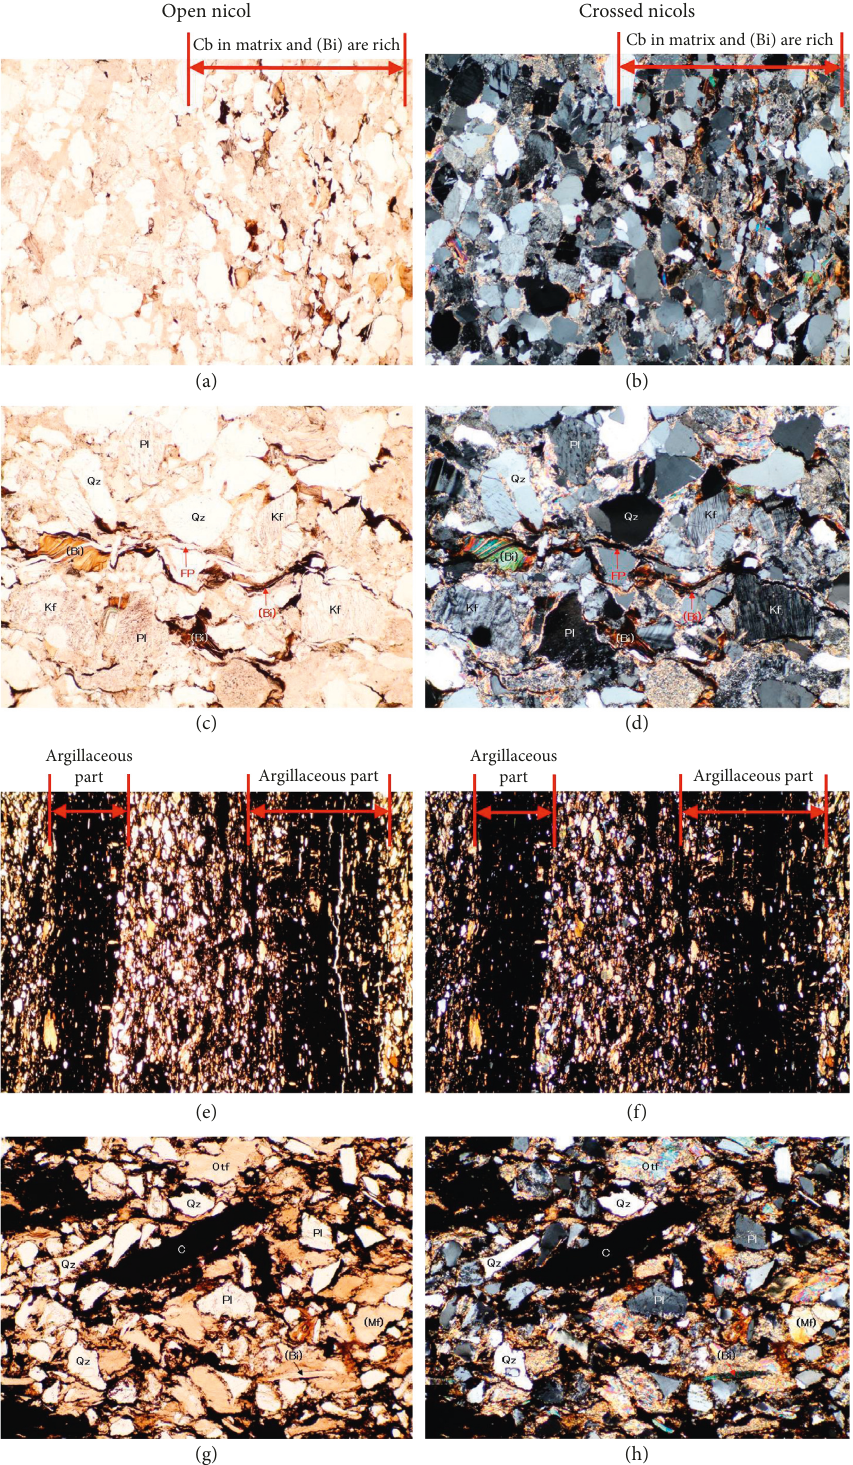
Figure 9: Microscopic images of Mchenga arkose sandstone (a, b, c, d) and Mchenga fine-grained sandstone (e, f, g, h). Qz: quartz; Kf: orthoclase; Pl: plagioclase; Bi: biotite; Mf: mafic minerals; C: coaly substances; Cb: carbonate minerals; ( · ): pseudomorphism; FP: fracture. Widths of the images are 6.0mm for (a), (b), (e), and (f); 2.5mm for (c) and (d); and 1.2mm for (g) and